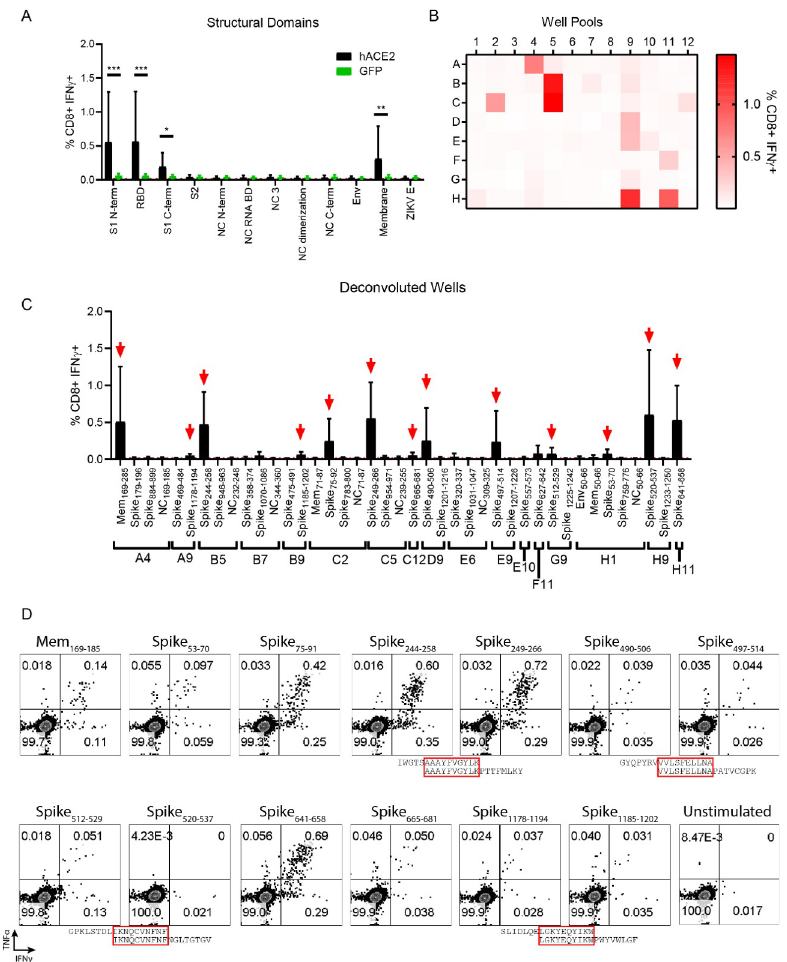
Fig 4. In vivo transfection of hACE2 mRNA permits the detection and functional mapping of SARS-CoV-2 specific CD8+ T cell responses. ( A ) CD8+ T cell responses to pooled peptide domains. Each equimolar peptide library pools was demarcated by peptides contained in functional domains of each protein (11 total pools). Five days post boosted infection with SARS-CoV-2 following mRNA transfection harvested splenocytes were stimulated with each peptide pool. Cells were stained to evaluate the frequency of responsive CD8+ T cells by IFN- γ expression. ( B ) CD8+ T cell responses to smaller well peptide pools. Each library was incorporated into multiple 96-well plate formats ( S5 Fig ). Within the same layout, wells from the plates were pooled such that all A1 peptides were pooled, all A2 peptides, etc. maintaining the 96-well plate format reducing the overall number of screened samples. As in 3A splenocytes boosted mice were harvested and stimulated with each peptide pool. The frequency of IFN- γ + CD8 + T cells—the magnitude of which represents responsiveness to a peptide in the pool, is enumerated in a heat map format as the average responses of 3 mice. ( C ) Identified potential well hits, were deconvoluted and used individually to stimulate splenocytes from hACE2 transfected, SARS-CoV-2 infected mice. 13 potential epitopes were identified (marked with red arrows) as defined by the frequency of IFN- γ + CD8 + T cells being at least 2-fold above background (stimulated with vehicle) in at least 3 of the 4 mice screened. ( D ) Representative flow cytometry plots displaying IFN- γ and TNF α expression in CD8 + T cells for each putative epitope in comparison to a vehicle control. Due to the overlapping nature of the peptide library, Spike 244-258 and Spike 249-266 , likely are demonstrating responsiveness to the same peptide epitope. 3 other instances of this phenomenon are denoted with red boxes surrounding the amino acid sequence overlap. Statistical significance was determined by Mann-Whitney test ( � p = .0159, �� p =